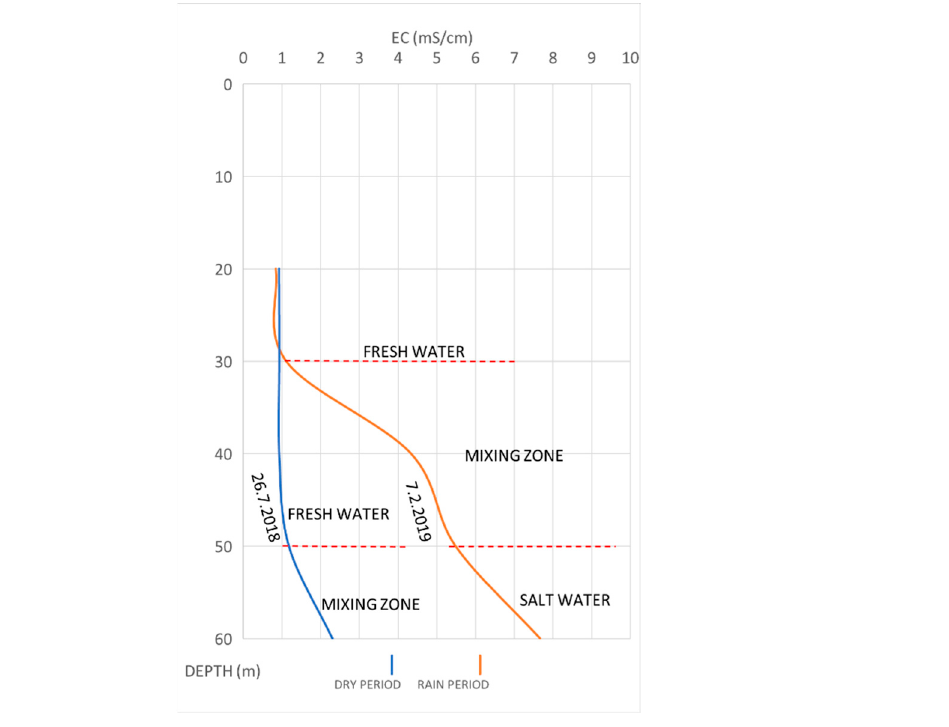
Figure 6. Electrical conductivity by depth of the piezometric well BOLJ-1 in dry and rainy period. Table 2. Average, minimum, and maximum values of parameters used for analysis (period 2017–2019).